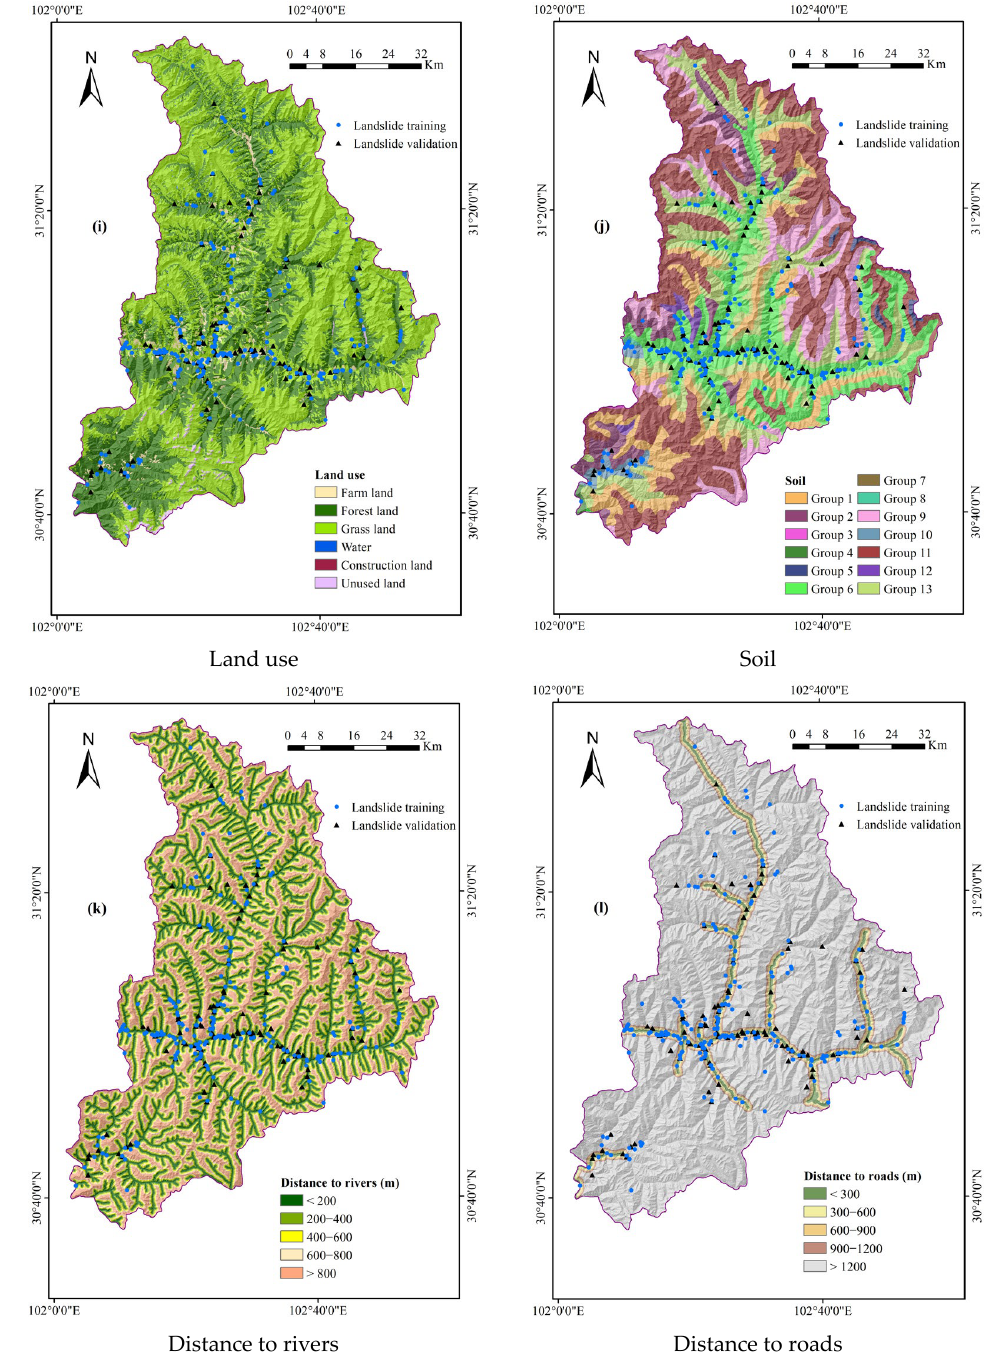
Figure 2. Landside conditioning factors.